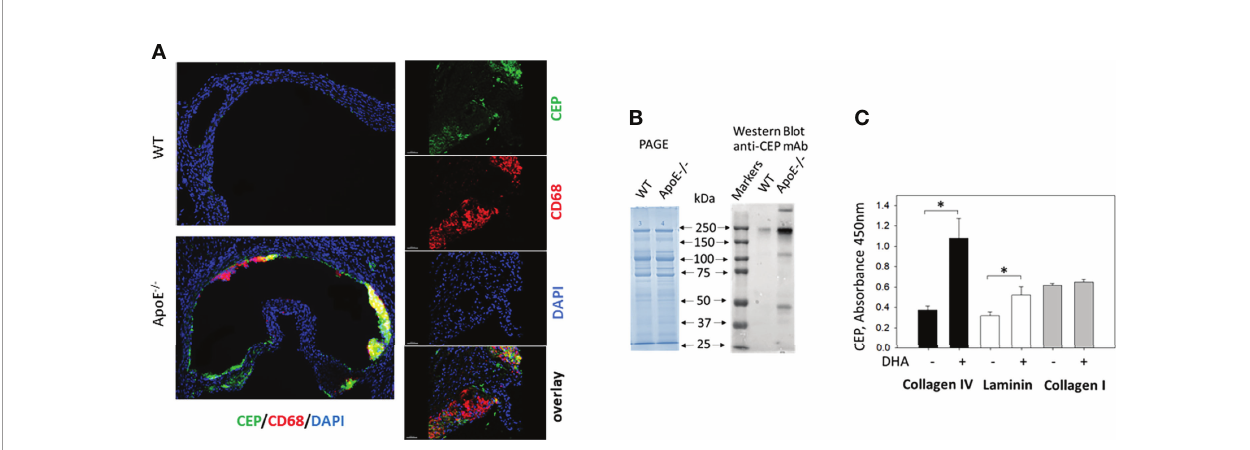
FIGURE 2 | CEP forms adducts with ECM proteins during in fl ammation and oxidation of DHA. (A) CEP deposition in atherosclerotic lesions. Aortic sinuses were isolated from the ApoE-de fi cient mice after fi ve weeks on a western diet. The sections were prepared and immunostained with anti-CEP (green) and anti-CD68 (red) antibodies. The crosssection of entire aorta roots (right) and 200x magni fi ed inlet (left) are shown (scale bar 200 m m). (B) Electrophoresis (PAGE) and Western blot analysis with anti-CEP antibody of digested aortas. Aortas of ApoE-/- and WT mice were digested, cells were separated and the non-cellular contest was analyzed by electrophoresis with Coomassie Blue and Western Blot (7% PAGE) with anti-CEP antibody (representative experiment from 4 performed). (C) Generation of CEP- modi fi ed ECM proteins. Collagen IV, collagen I, and laminin were coated on a 96-well plate and incubated in the presence (or absence) of 2 m M DHA in 20 mM HEPES, 150 mM NaCl, 0.01% H 2 O 2 , and 1mM CaCl 2 in an oxygen-free environment (under argon atmosphere) for 18 hours at 37°C. After incubation, the plate was incubated with an anti-CEP polyclonal antibody (0.9 m g/ml) followed by goat-anti-rabbit HRP conjugated antibody. The binding was developed using a TMB-ELISA substrate solution (Pierce). The result was detected by plate reader using wavelength 450 nm. Statistical analyses were performed using Student ’ s paired t -tests from 3 independent experiments. *P <